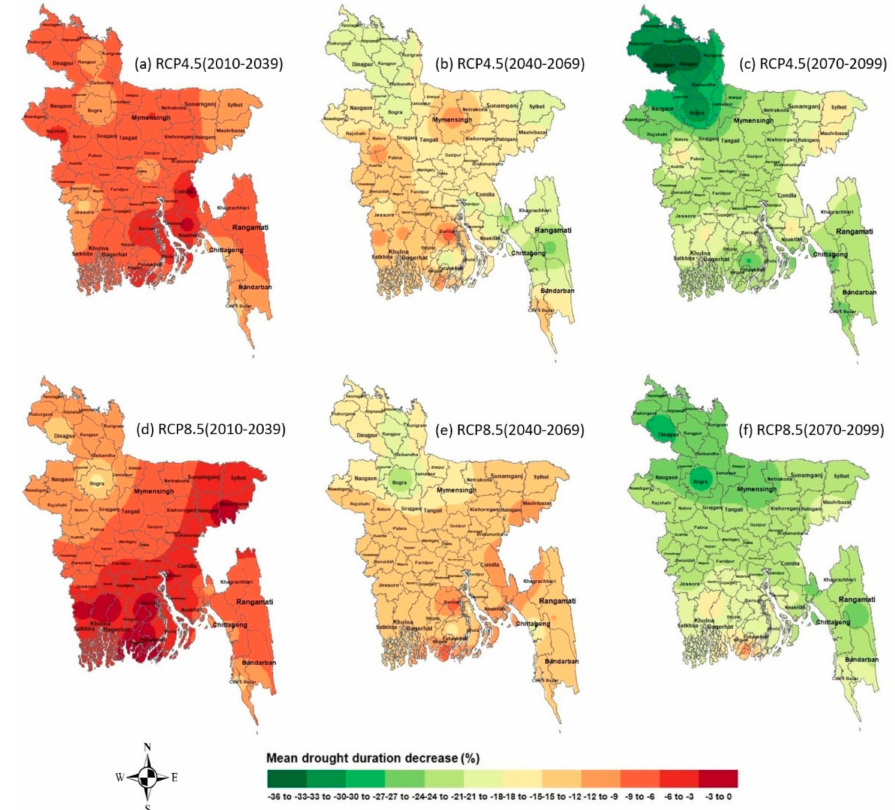
Figure 10. Percentage (%) change in the mean drought duration over Bangladesh for the 2010s (1st column), 2040s (2nd column), and 2070s (3rd column) under the RCP4.5 (upper row) and RCP8.5 (lower row) scenarios relative to the baseline period